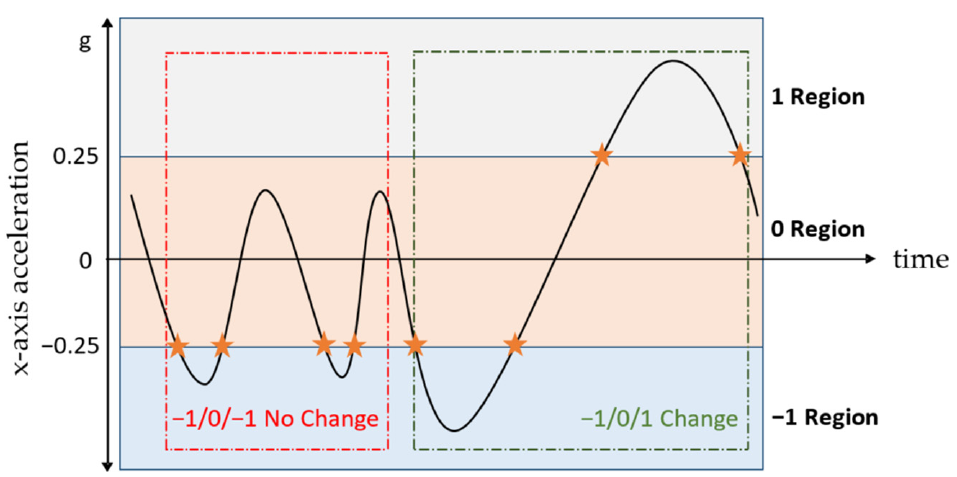
Figure 4. X -axis acceleration signal, with stars denoting region changes. The red area does not contain a zero-crossing, whereas the green one does. The y -axis lacks unit of measurement because succession of events in time is of interest and not the scale.